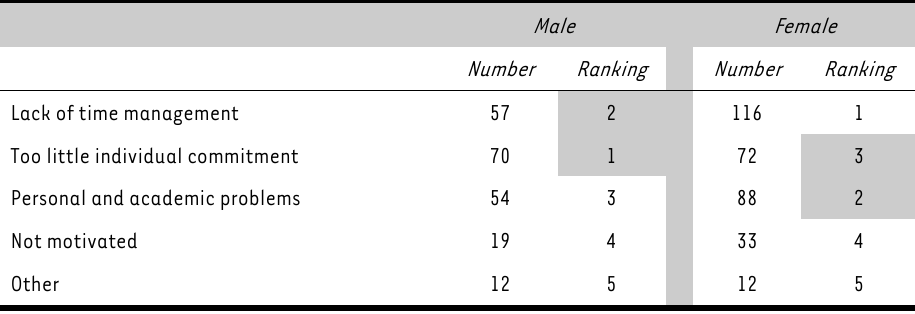
Factors hindering own success split between genders